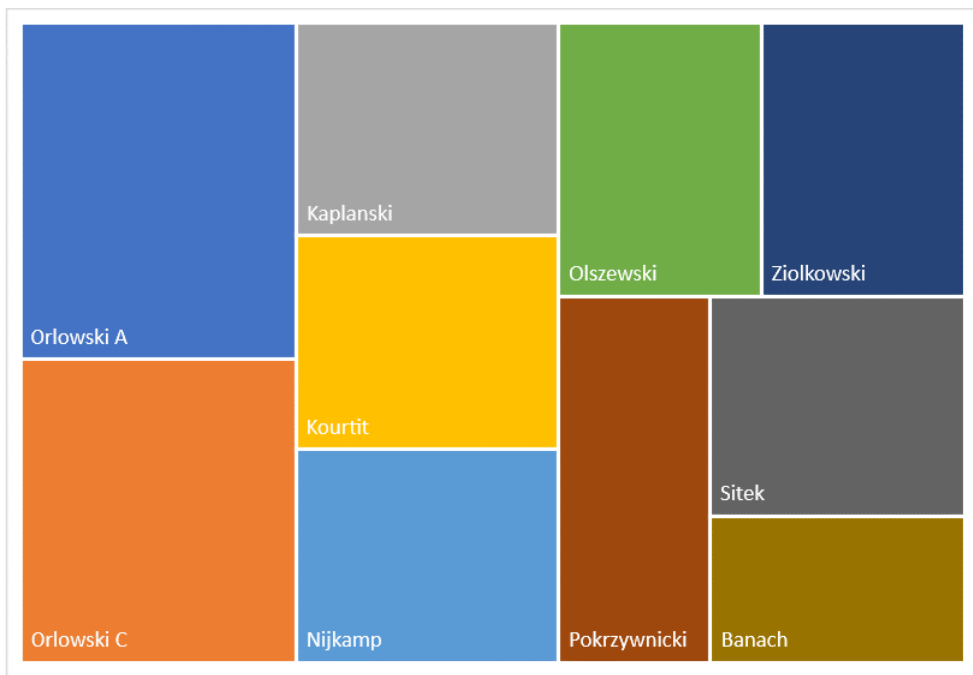
Figure 13. An overview of Polish authors publishing on the topic of Smart cities. Source: own analysis as per Web of Science (2022).